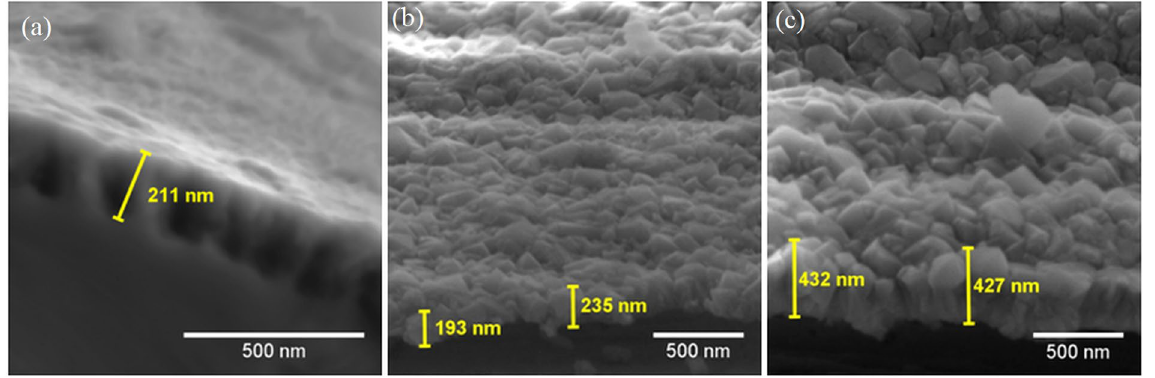
Figure 5. Secondary electron micrographs of NCD layer. ( a ) Thickness of 300 nm before 30 days of exposure to 360 °C hot water. ( b ) Thickness of 300 nm after 30 days of exposure to 360 °C hot water. ( c ) Thickness of 500 nm after 15 days of exposure to 360 °C hot water. No important change in the NCD layer thickness was detected, thus confirming the high durability of the layer.